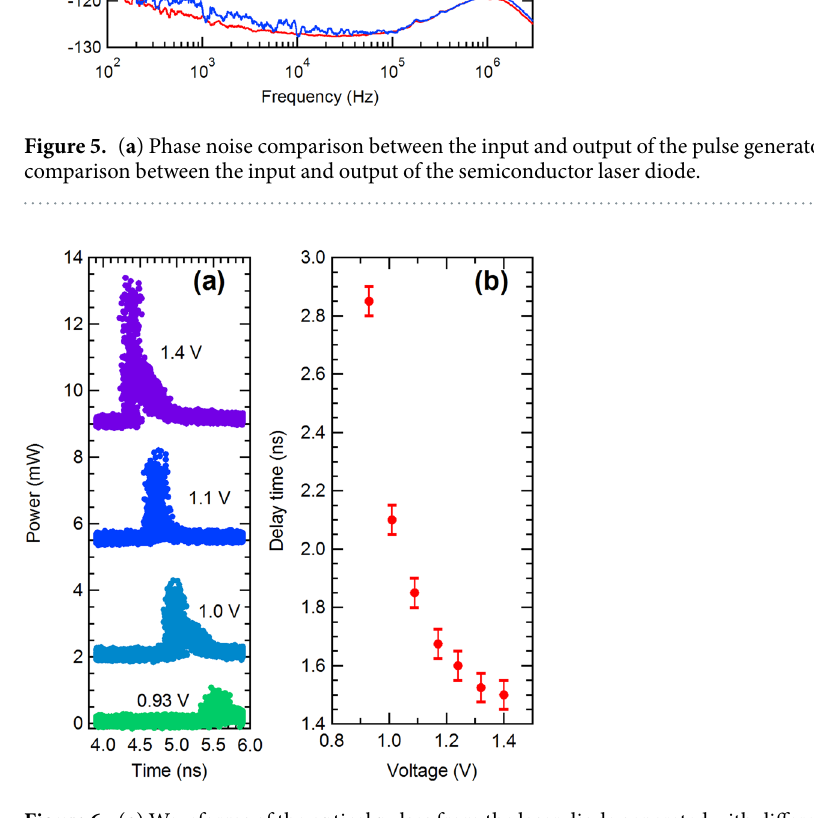
Figure 7 summarizes the tuning ability of the electric pulser driven semiconductor laser system. The tuning range of the electric pulser is 8 ps–270 ns, and consequently, the optical pulse width can be tuned from 100 ps to 270 ns. The peak power of the optical pulse is approximately 4 mW, which is a value suitable for use as seed lasers, for fiber amplifications. Note that the 100 ps minimum optical pulse width is generated from an electrical pulse width of 1.5 ns, which is much longer than the 80 ps minimum that the electric pulser can achieve. The 100 ps optical pulse width is